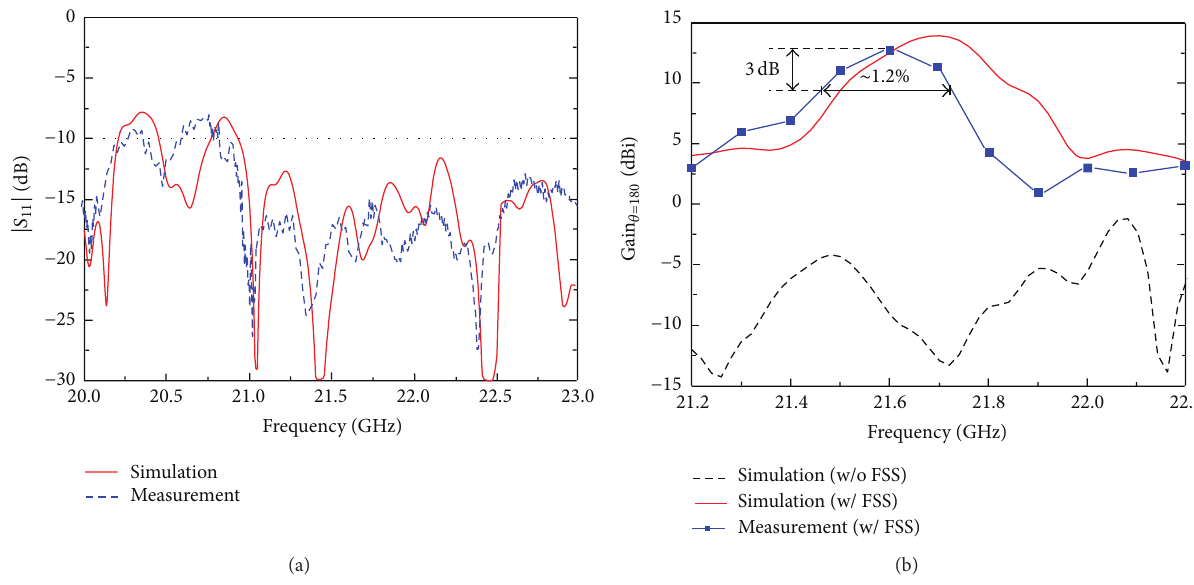
Figure 12: Measured and simulated (a) reflection coefficients and (b) boresight gains of the proposed Fabry-P´erot cavity antenna.